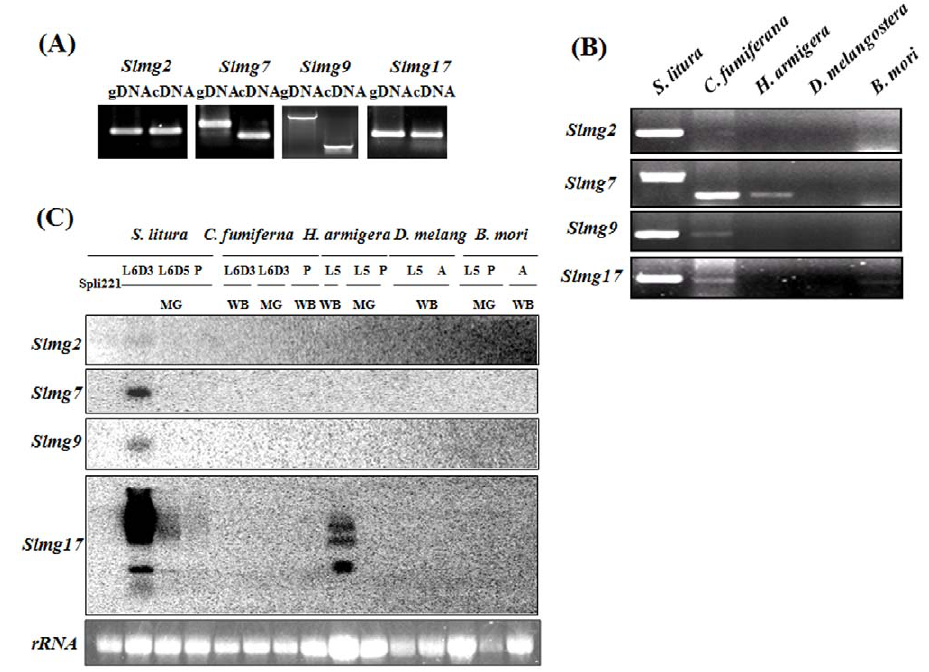
Figure 3. Presence and expression of the four larval midgut-predominant genes. (A) Analysis of presence and expression of the four larval midgut-predominant genes ( Slmg2 , Slmg7 , Slmg9 and Slmg17 ) in Spodoptera litura by using genomic DNA and cDNA; (B) PCR amplification of the four genes in S. litura , C. fumiferana , H. armigera , B. mori and D. melanogastera using genomic DNA as templates. (C) Northern blot analysis of expression of the homologous genes in S. litura , C. fumiferana , H. armigera , B. mori and D. melanogastera . Ten micrograms of total RNA isolated from the midgut (MG) and the whole body (WB) was separated on denaturing 1% MOPS-formaldehyde gel. 32 P-labeled EST fragments of corresponding S. litura genes were used as probes. Ethidium bromide stained rRNA indicates the equal loading of total RNA. Spli -221: an embryogenic cell line of S. litura ; L5: 5 th instar larvae; L6D0: the day (white head) of ecdysis from 5 th to 6 th instar stage; L6D3: 3 day after ecdysis into 6 th instar stage; P: pupal stage; A: adult stage.